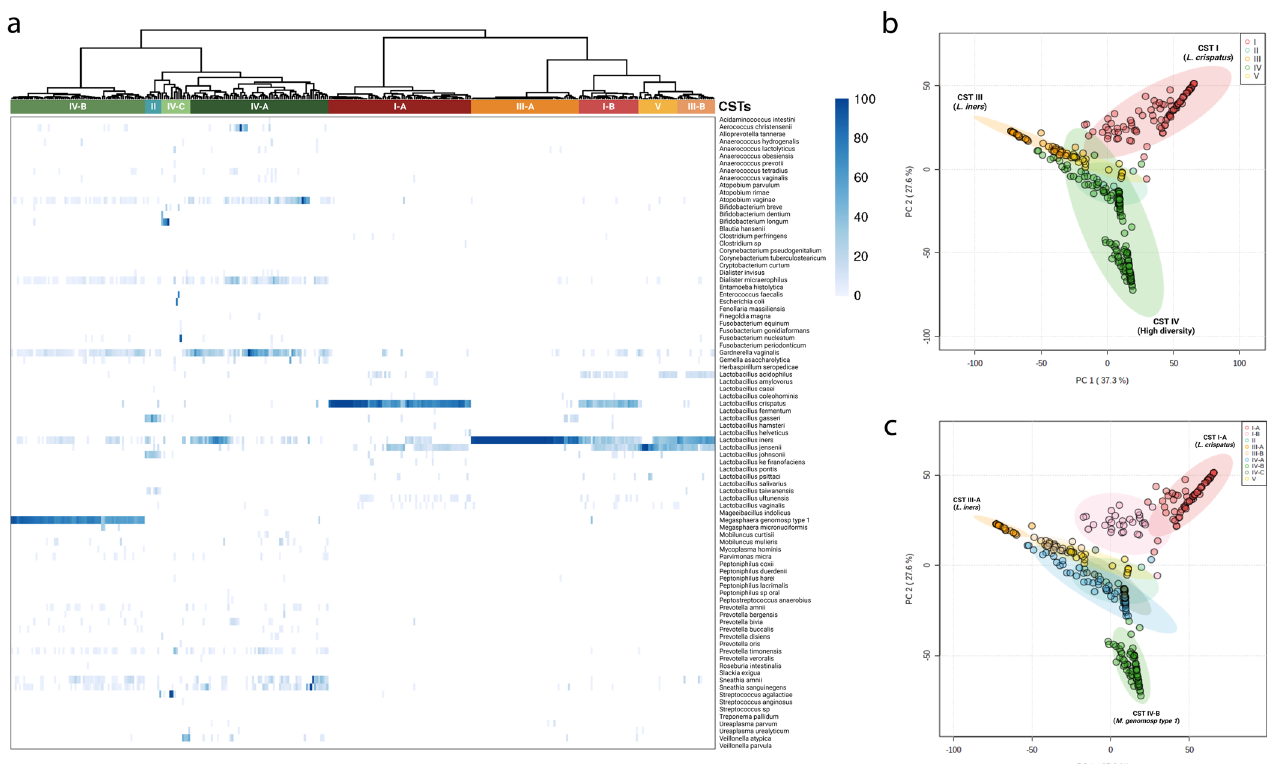
Fig. 1 Classical and newest subgroups of community state types within the cervicovaginal microbiome. Unsupervised clustering analysis shows that the CVM from our “ Health ” cohort ( n = 341) groups in clusters resembling the classical fi ve CSTs and subclusters consistent with the subclassi fi cation for CSTs I, III, and IV. Samples clustered in CSTs according to the dominant bacterium and their microbial composition (I-B, III-B). Clustering distance: Manhattan. Normalized values represent relative abundances ( a ). Separation of our cohort by PC1 and PC2 shows the clusters representing the fi ve traditional CSTs ( b ), and at the same time, such clusters fi t within the CST subdivisions ( c ). The microbial species L. iners ( − 0.81) and L. crispatus (0.57) have a negative and positive correlation, respectively, with PC1. In contrast, both L. iners (0.35) and L. crispatus (0.63) show a positive correlation with PC2, while M. genomosp type 1 ( − 0.64) and G. vaginalis ( − 0.15) exhibit a negative correlation with PC2 (Supplementary File 1). These species associate with the CSTs III-A, I-A, and IV, respectively, and dominate the PCA distribution ( b , c ). Source data are provided as a Source data fi le. CSTs: community state